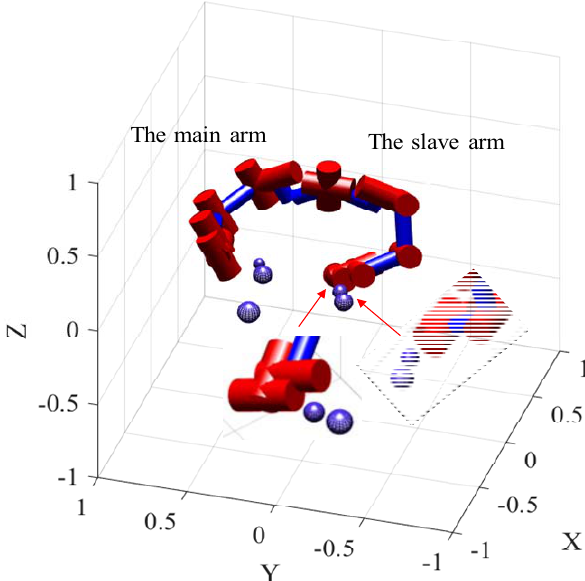
Figure 13. Static obstacle avoidance.